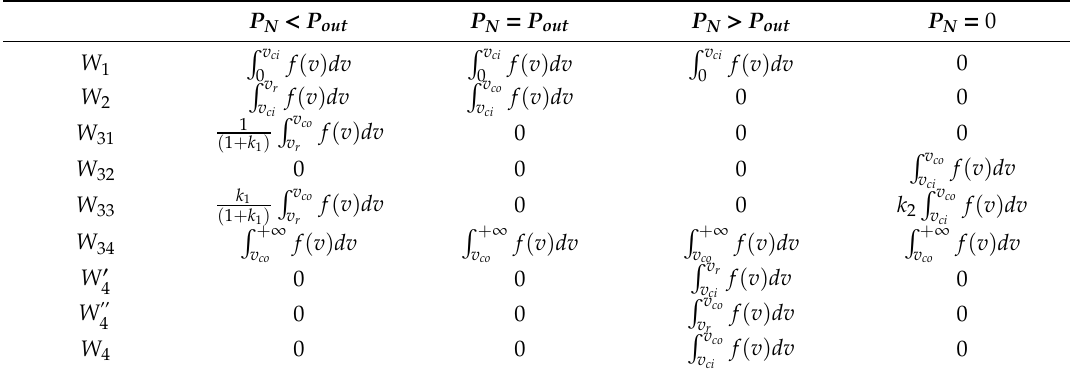
Table 2. Evaluation method of weight parameters during operational